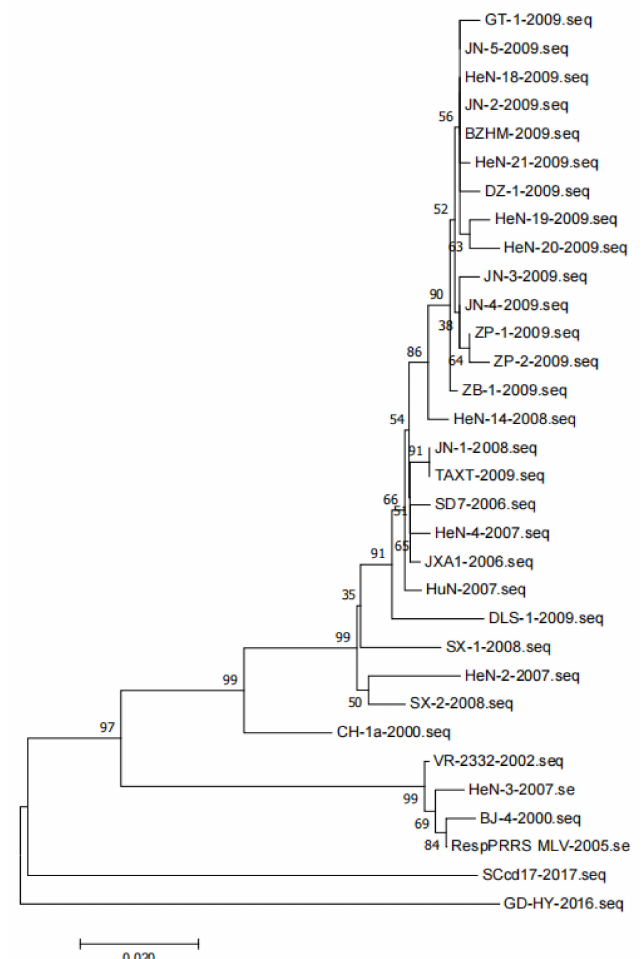
Figure 3. Phylogenetic tree of PRRSV based on the ORF5